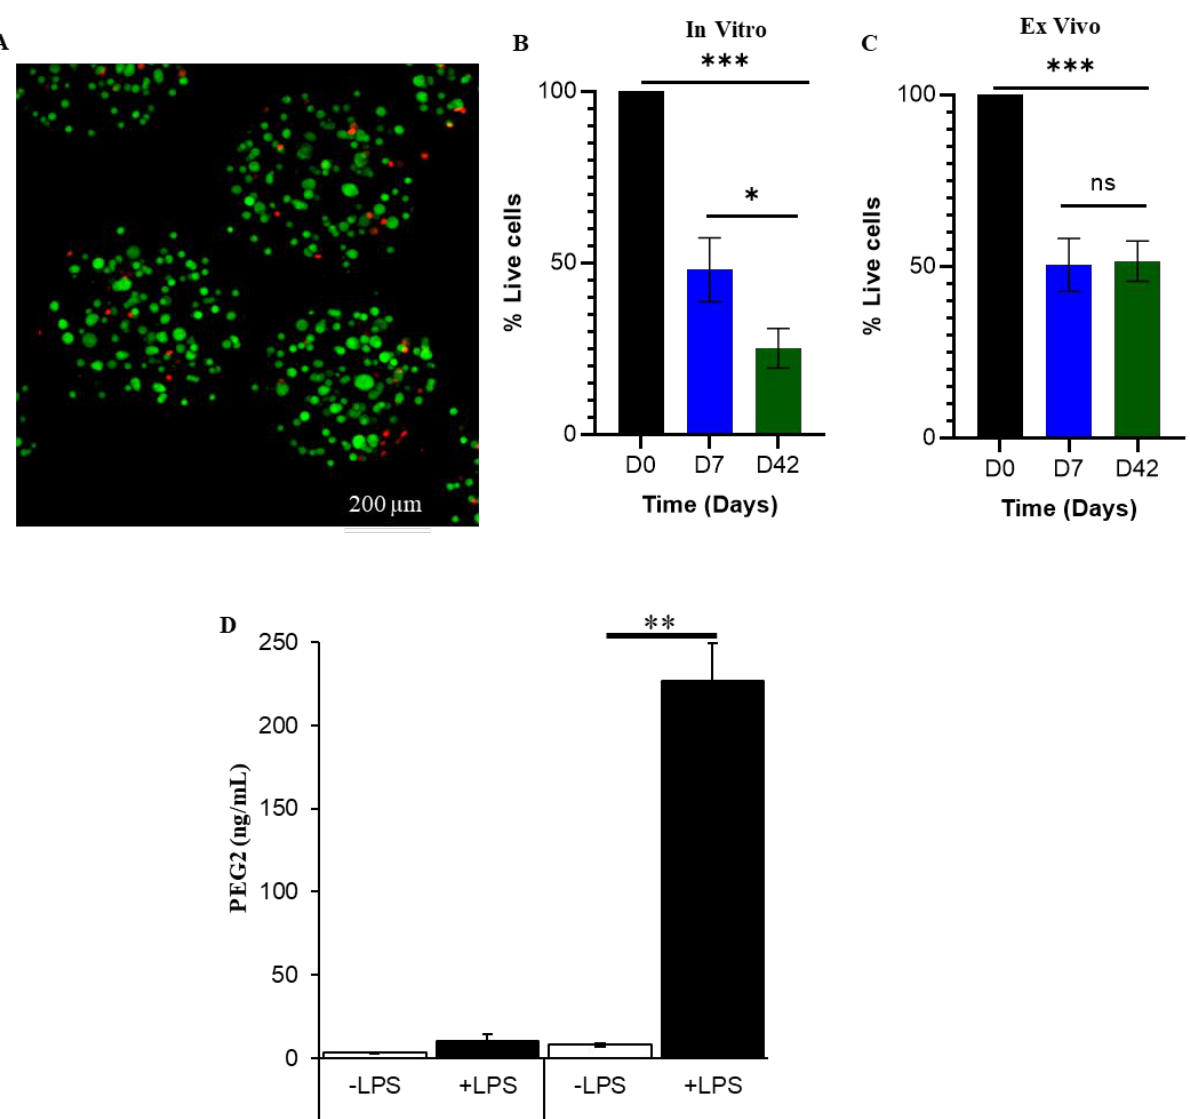
Figure 1. eMSC viability and biological activity in vitro and ex vivo. ( A ) In vitro eMSC live (green)/dead (red) staining same day (day 0) after preparation of eMSC; ( B ) Survival of eMSC in vitro ( C ) Survival of eMSC ex vivo after recovery from cauda equina of SCI rats; (cell number at day 0 = 86.0 ± 9.79, n = 6). On day 0, cells in eMSC were stained (number of cells/capsule = 56.6 ± 7.44, n = 5) after washing them from the needle hub post-injection. eMSC were incubated in vitro for 0, 7, and 42 days as noted, and eMSC from the same batches were injected in SCI rats and retrieved 7 and 42 days later (ex vivo, ( B ). The % of live cells was determined from confocal micrographs. One- way ANOVA followed by Tukey’s test was used to analyze the data (mean ± SEM). * p < 0.05 and *** p < 0.001. ( D ) PGE2 expression from eMSC in vitro and ex vivo after recovery from a 42-day incubation in vivo in the cauda equina as in ( C ). The eMSC recovered at 42 days were incubated for 24 h without LPS (−LPS) and after removing the conditioned medium it was replaced with fresh medium containing 1 µg/mL LPS (+LPS) for an additional 24 h. Student t -test was used for statistical analysis. ** p < 0.01.